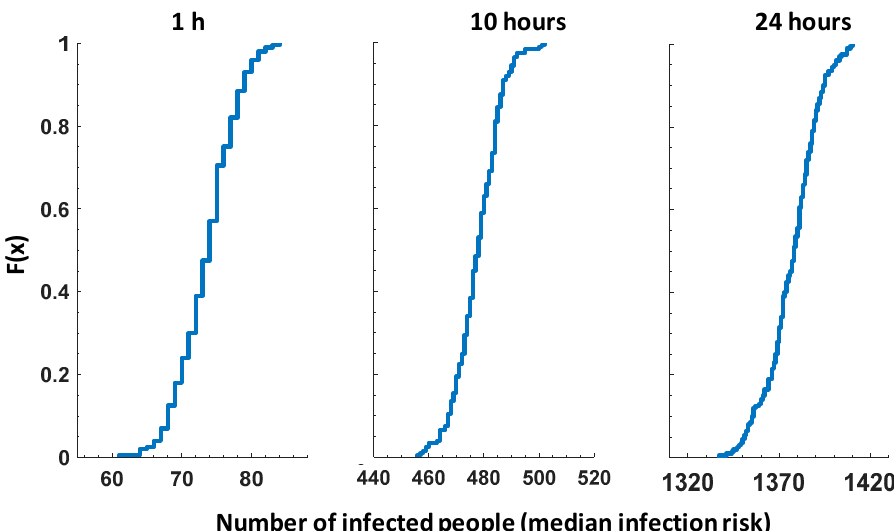
Figure 6. Comparing the probability distribution of the number of infected people over a four-day period for 200 Monte Carlo simulations for each duration of PDCs: 1, 10, and 24 h; Cryptosporidium concentration in sewage = 560 oocysts/L.